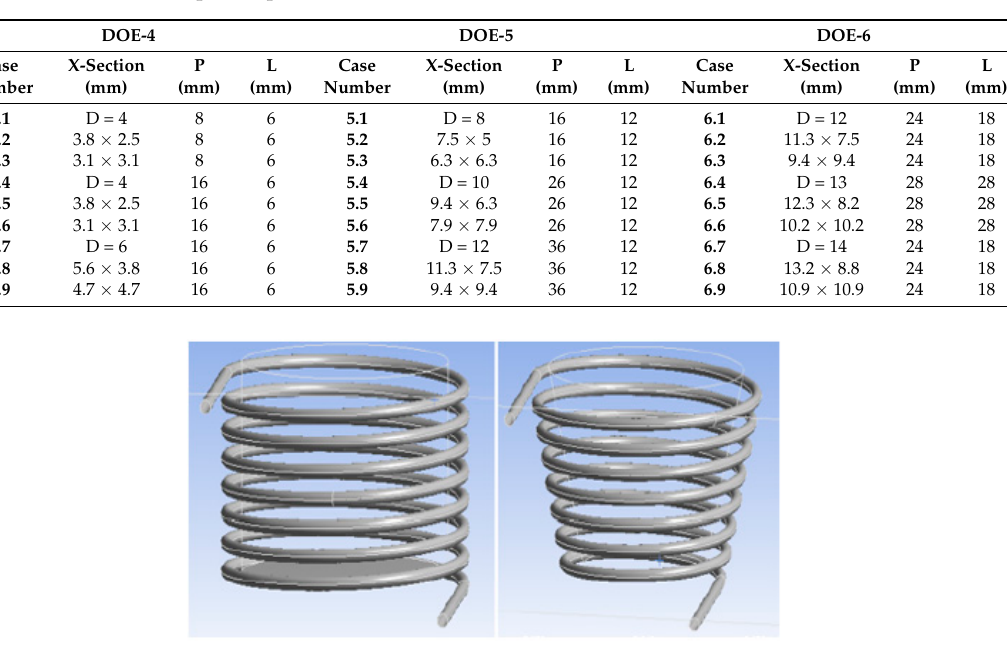
Figure 6. Generic cylindrical and conical configuration of conformal cooling channels.